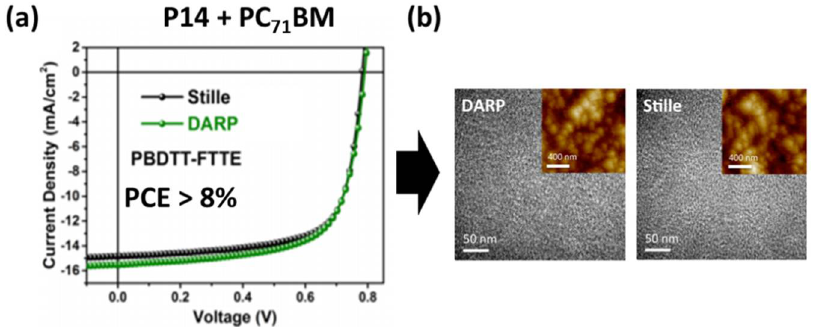
Figure 6. ( a ) J-V curves for Stille and DHAP produced PBDTT-FTTE with PC 71 BM; ( b ) AFM Images comparing the morphology of Stille and DHAP samples of P6 , blended with PC 71 BM. Reproduced with permission from ( J. Am. Chem. Soc. 2016 , 138 , 15699–15709). Copyright (2016) American Chemical Society.